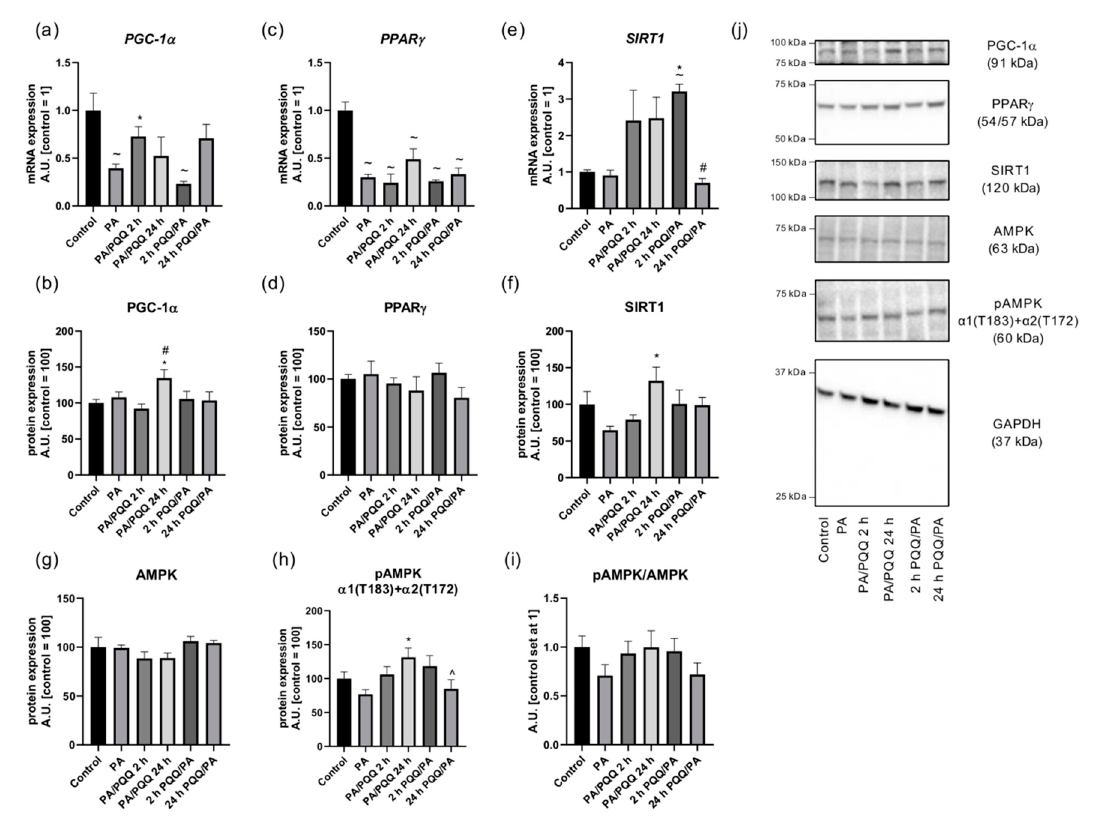
Figure 5. E ff ects of short- and long-time incubation with PQQ on the mRNA and protein levels of ( a,b ) peroxisome proliferator activated receptor γ co-activator 1 α , ( c,d ) peroxisome proliferator activated receptor γ , ( e,f ) sirtuin 1, ( g ) 5 (cid:48) AMP-activated protein kinase, ( h ) phosphorylated 5 (cid:48) AMP-activated protein kinase and ( i ) pAMPK / AMPK ratio in L6 myotubes. ( j ) Representative Western Blot data. The control is set as 1 (mRNA, ratio) or 100 (protein). The values are presented as mean ± SEM and are based on six independent determinations. ANOVA with a post hoc Tukey’s test was applied. ~ p < 0.05, study groups versus control; * p < 0.05, PQQ-incubated groups versus palmitate group; # p < 0.05, time-dependent di ff erences (long- vs. short-time incubation with PQQ); ˆ p < 0.05, sequence-dependent di ff erences (pre-incubation with PQQ vs. post-incubation with PQQ). ANOVA: analysis of variance; GAPDH: glyceraldehyde 3-phosphate dehydrogenase; mRNA: messenger RNA; PA: palmitic acid; PQQ: pyrroloquinoline